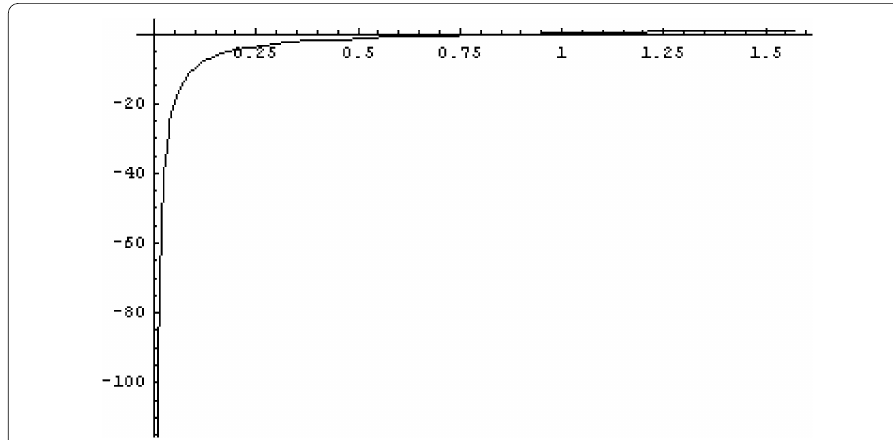
Figure 4 The graph of the function g ∗ , where θ ∈ (0, π